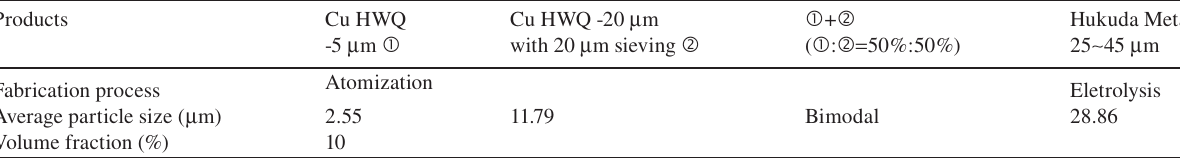
Table 1 Various kinds of Cu powders for fabrication of carbon fi ber preform. Products